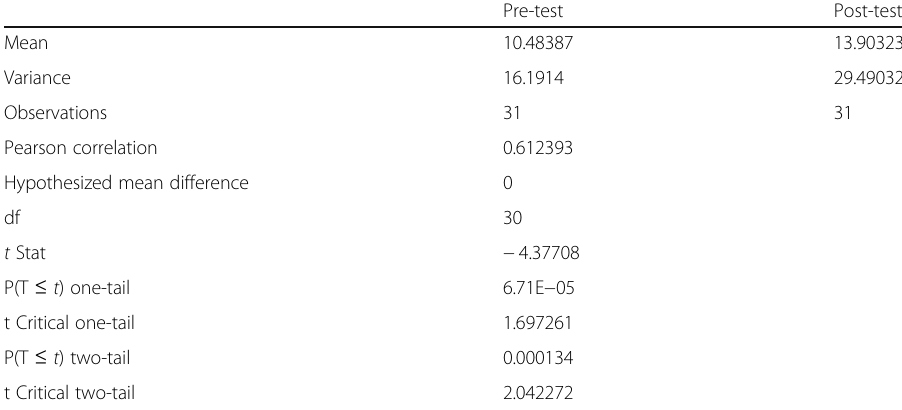
Table 2 Result of pair sample t test on pre- and post-test scores of the students involved in second cycle intervention ( n = 31)